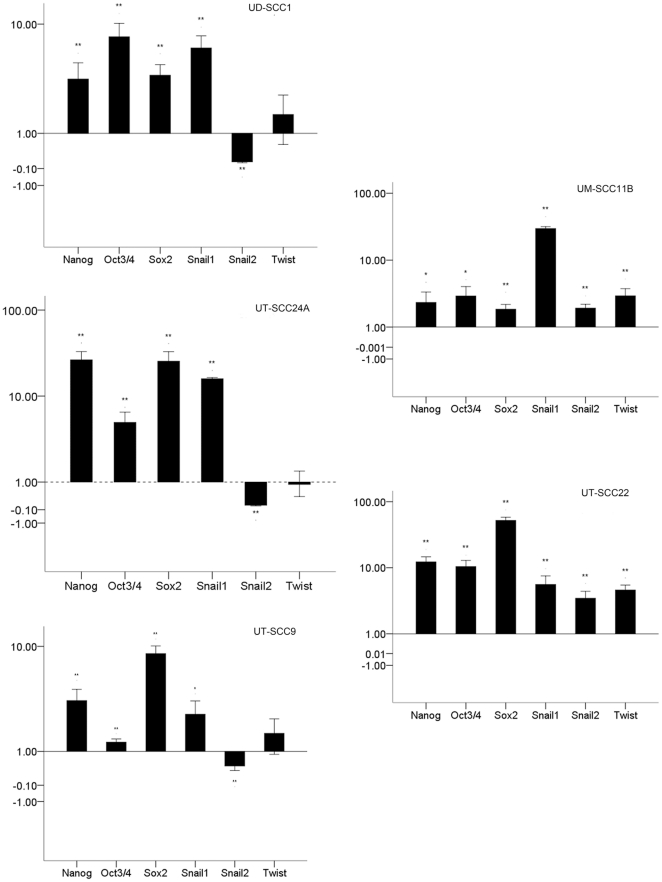
Quantitative PCR analysis of mRNA expression of stemness-related transcription factors.Messenger RNA isolated from spheroids and monolayer cultures was quantified for expression of the indicated TF. The ratio of expression in spheroid to monolayer cells is given. Significant differences were * p<0.05; ** p<0.01. The mRNA level of stemness-related TF Nanog, Oct3/4, and Sox2 were increased remarkably in spheroids. The key TF in EMT Snail1 was also increased in all spheroids but another two TF involved in EMT, Snail2 and Twist, showed an expression pattern depending on the CD44/CD24 status.